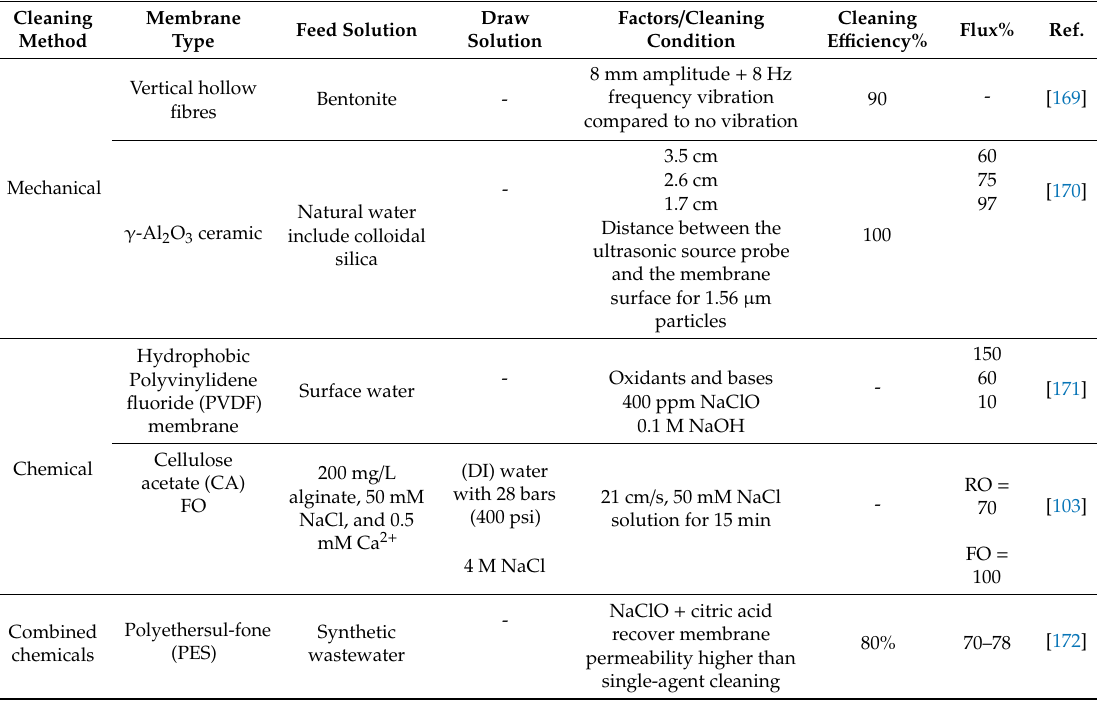
Table 3. Cleaning protocols for fouled forward osmosis (FO)